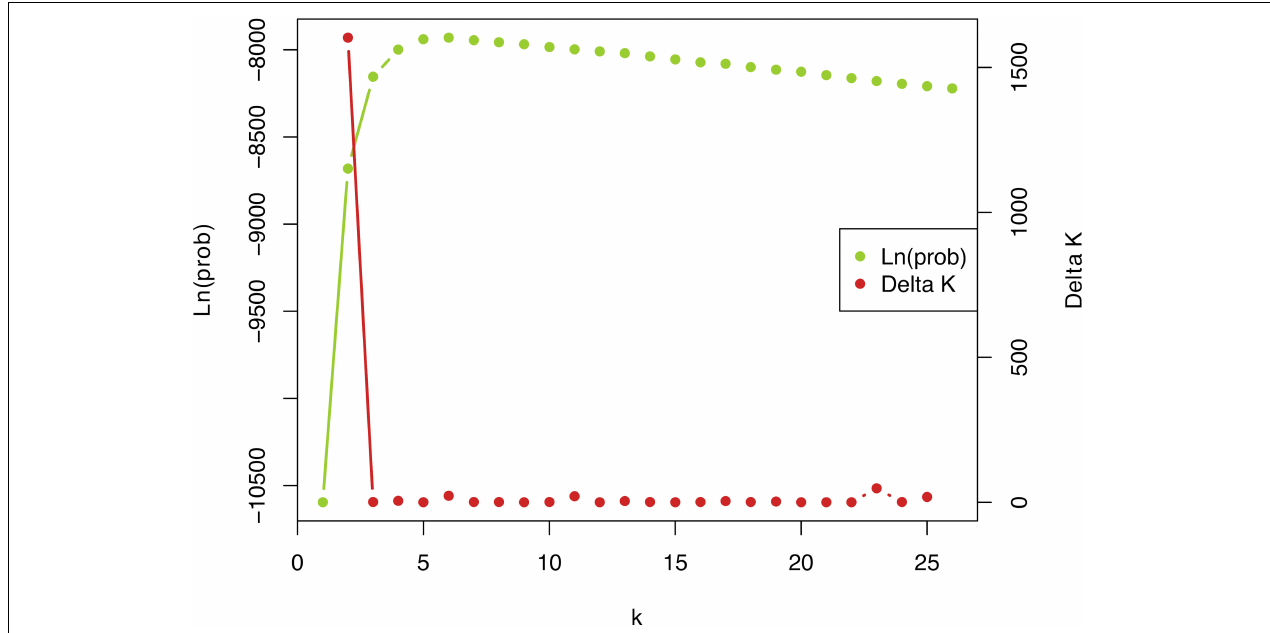
FIGURE 3 | Plot of (cid:49) K statistic of Evanno et al. (2005) detecting the number of K groups that best fit the data (best K = 2). TABLE 3 | Summary of genetic diversity of populations of P. linearis , P. dioica and the winter form of P. dioica by geographical areas. H S Detected nuclear hybrid Detected rbcL